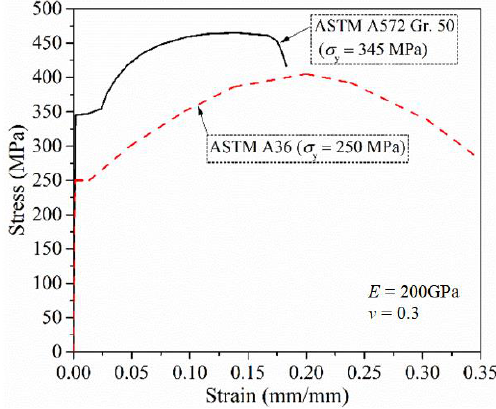
Figure 3. Constitutive behavior of steel.